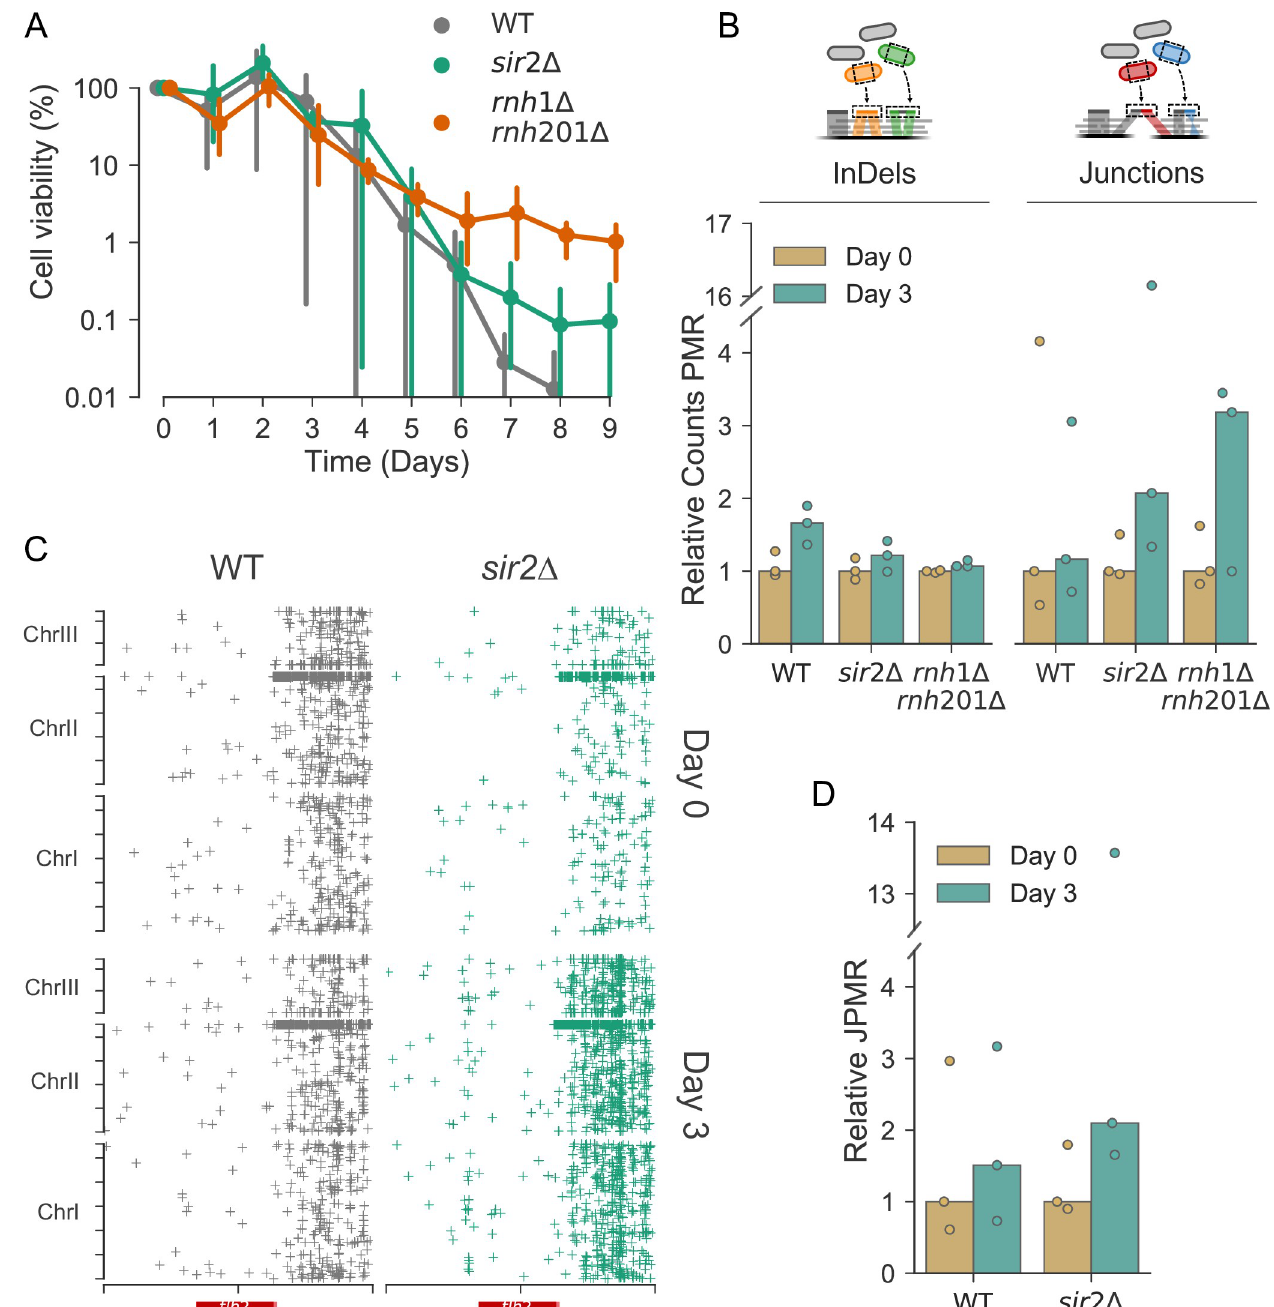
Fig 5. Age-associated phenotypes in sir2 and RNase H mutants. (A) High-throughput lifespan assay of rnh1 Δ rnh201 Δ (orange), sir2 Δ (green) and wild- type (grey) cells. Points show the mean of three independent repeats, and bars show the 95% confidence interval. Samples for sequencing were taken at Day 0 and Day 3, because too few live cells were present for sequencing analyses at later timepoints. (B) Counts of indels (left) and junctions (right) per mapped read (PMR), relative to Day 0, in wild-type, sir2 Δ and rnh1 Δ rnh201 Δ cells. Dots show relative counts PMR for each replicate. (C) Scatter plot as in Fig 4A showing the coordinates of junctions at the hotspot surrounding tlh2 . The x-axis shows the coordinates of junctions in 20kb region surrounding the tlh2 hotspot ( tlh2 gene depicted in red); the y-axis shows the coordinates of the corresponding junctions across the genome. Junctions from three repeats were pooled, per sample, for wild-type samples (left, grey) and sir2 Δ samples (right, green), both at Day 0 (top) and Day 3 (bottom). (D) Normalised data from (C). All junctions within the region were collected for each replicate and normalised to the number of mapped reads in that sample. Data is shown relative to the median at Day